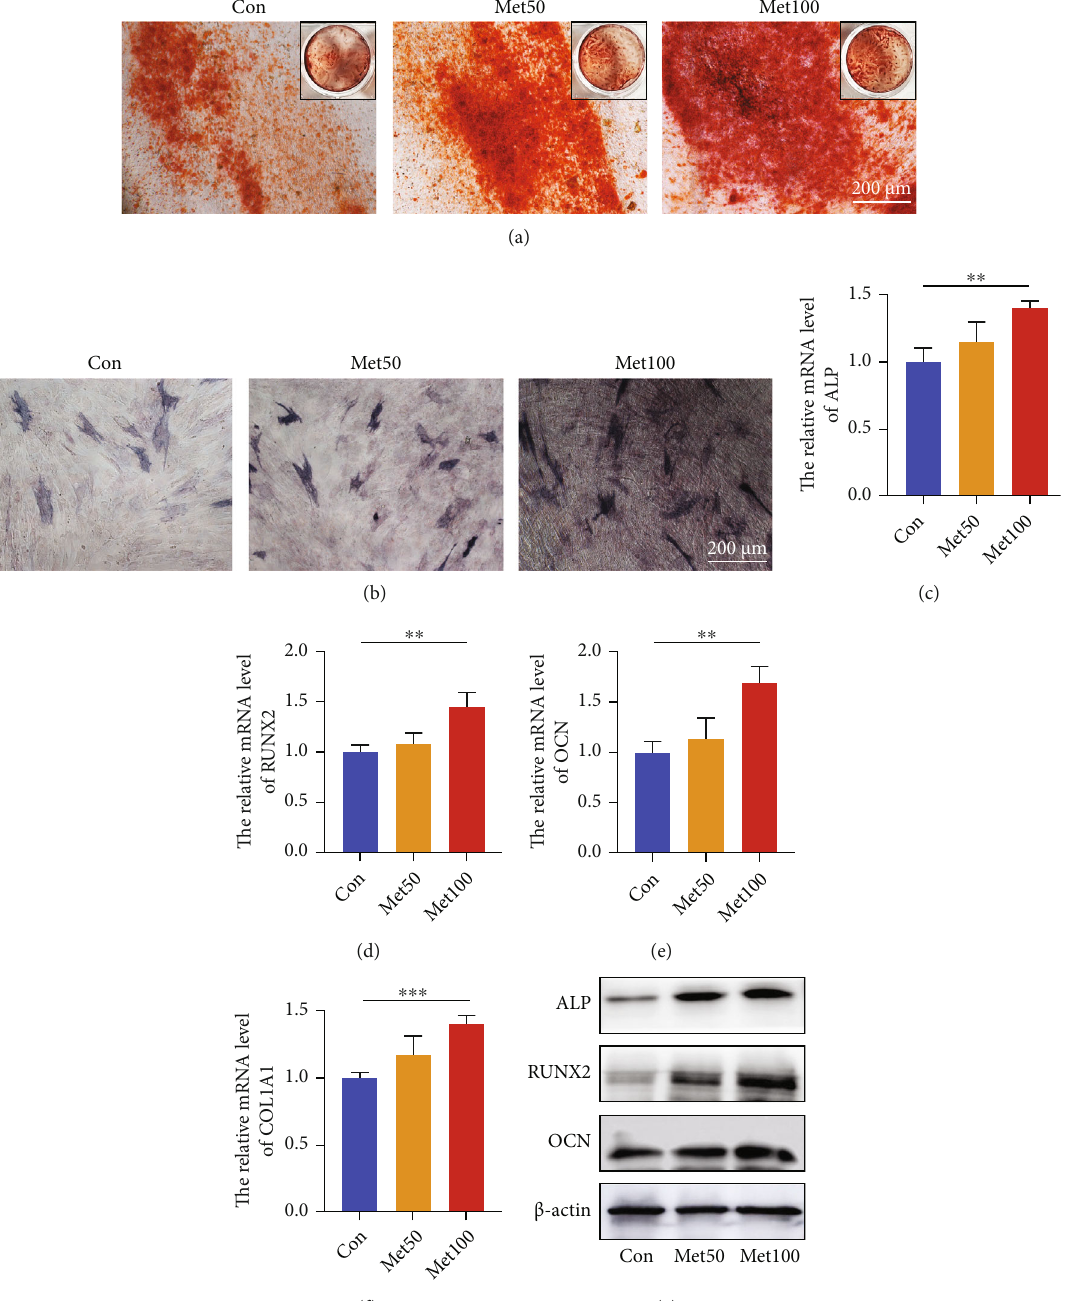
Figure 3: Metformin enhanced osteogenic di ff erentiation capacity of UC-MSCs. (a) Osteogenically di ff erentiated cells were identi fi ed with Alizarin Red staining after 21 days incubation. Scar bar = 200 μ m (100x). (b) ALP activity of UC-MSCs was evaluated after 7 days incubation. Scar bar = 200 μ m (100x). (c – f) Quantitative analysis of osteogenic genes expression by RT-qPCR, including ALP (c), RUNX2 (d), OCN (e), and COL 1A1 (f). n = 3 ; ∗∗ P < 0 : 01 , ∗∗∗ P < 0 : 001 . (g) Osteogenic proteins of ALP, RUNX2, and OCN were assessed by western